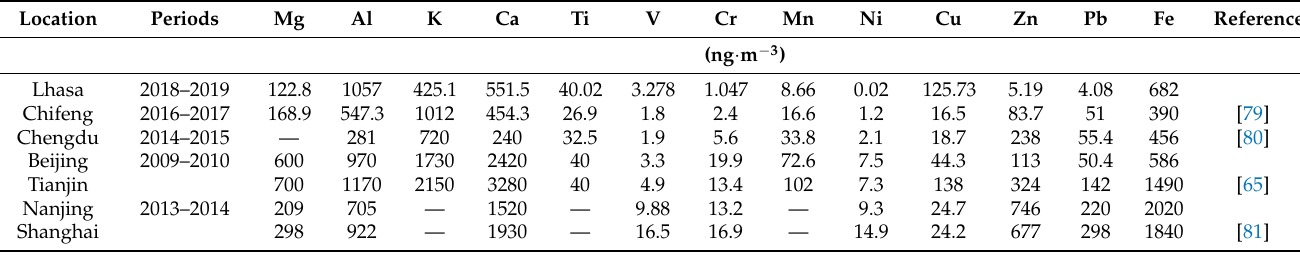
Table A1. Comparison of the mass concentrations of TEs (PM 3 ) with other cities in